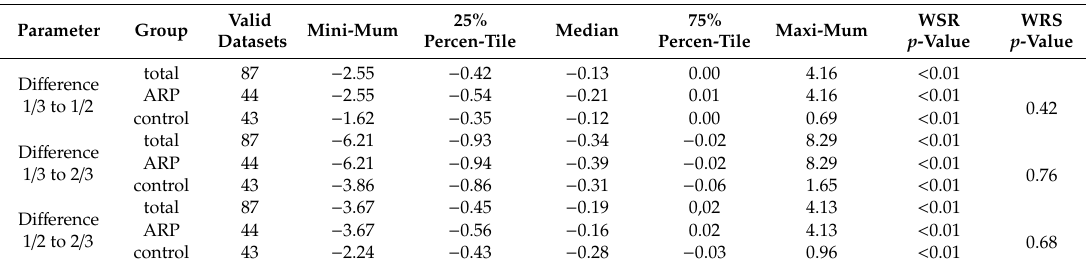
Table 3. Di ff erences in bone density among di ff erent measurement locations in the alveolus according to the overall group, the ARP-group, and the control group including maxima, median, and minima. The di ff erence of 0 was investigated using Wilcoxon signed-rank test and the group comparison was performed using Wilcoxon rank-sum test.